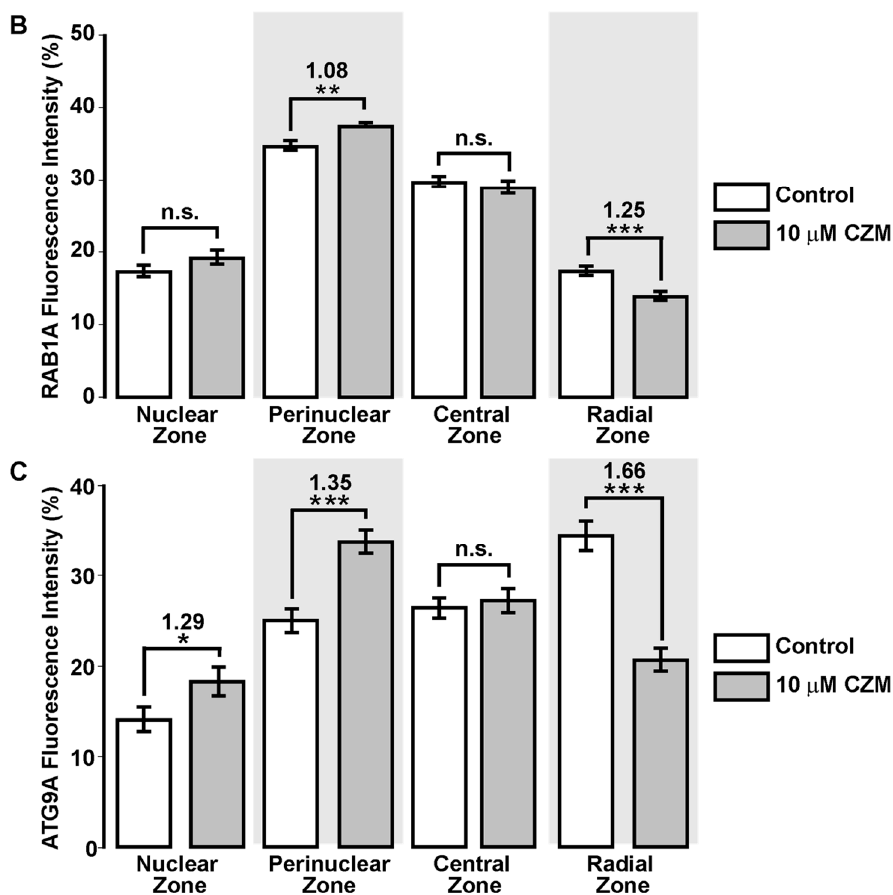
Figure 7. Redistribution of RAB1A and ATG9A to the Golgi apparatus with CZM. ( A ) Immunofluorescence analysis of endogenous RAB1A and ATG9A in H4 parental cells treated for 4 h either with the vehicle (DMSO; Control) (left panel) or CZM (right panel). Cells were fixed, permeabilized, and stained with a rabbit monoclonal antibody to RAB1A (clone D3X9S) (upper panel) and a rabbit monoclonal antibody to ATG9A (clone EPR2450(2)) (lower panel), followed by Alexa-594-conjugated donkey anti-Rabbit IgG. Scale Bar, 10 µ m. ( B ) Quantitative analysis of the fluorescence intensity of RAB1A upon treatment with CZM, in comparison to control cells. Statistical significance was determined by Student’s t-test. Bars represent the mean ± SEM of the fluorescent signal per cell area ( n = 227 cells). ** p < 0.01; *** p < 0.001; n.s., not significant. ( C ) Quantitative analysis of the fluorescence intensity of ATG9A upon treatment with CZM, in comparison to control cells. Statistical significance was determined by Student’s t-test. Bars represent the mean ± SEM of the fluorescent signal per cell area ( n = 95 cells). * p < 0.05; *** p < 0.001; n.s., not